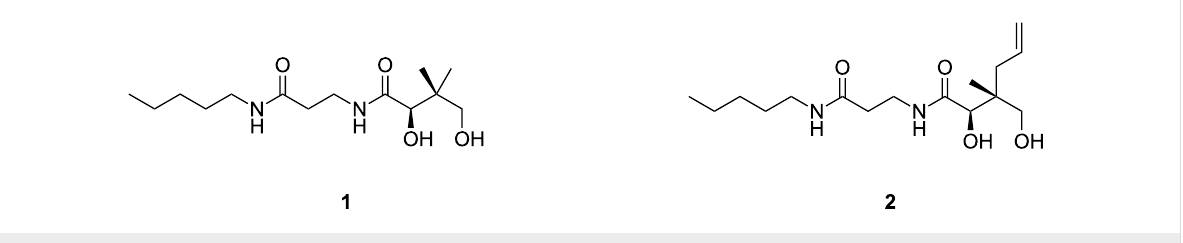
Figure 1: Chemical structures of N -pentylpantothenamide ( 1 ) and of its methyl allyl derivative 2 .